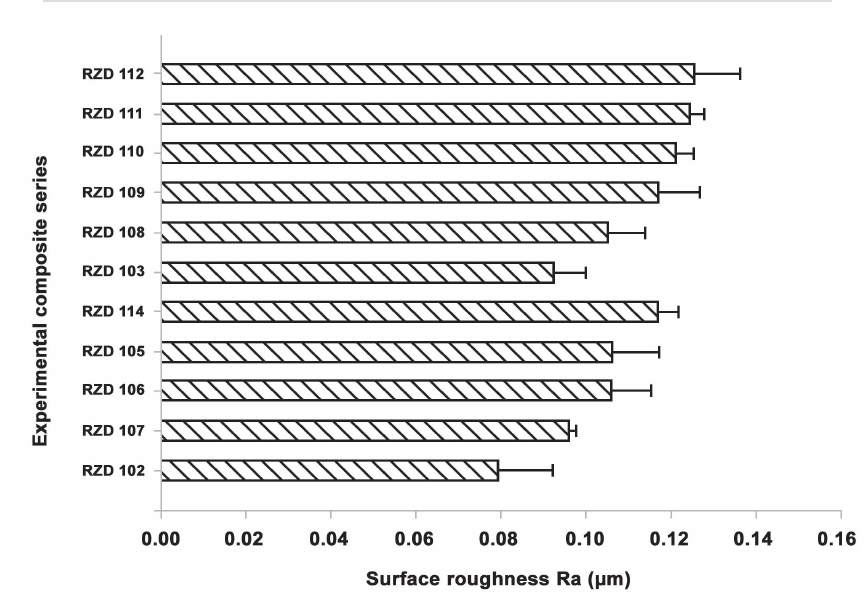
Figure 2- Surface roughness, R ( µ m) of the mono-, bi- and multi-modal experimental composite series a